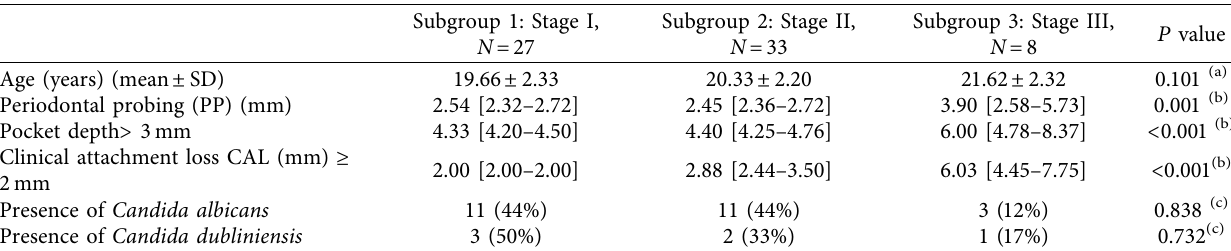
Table 3: Comparison of age, clinical variables, and presence of Candida albicans and Candida dubliniensis according to stages in periodontitis group.